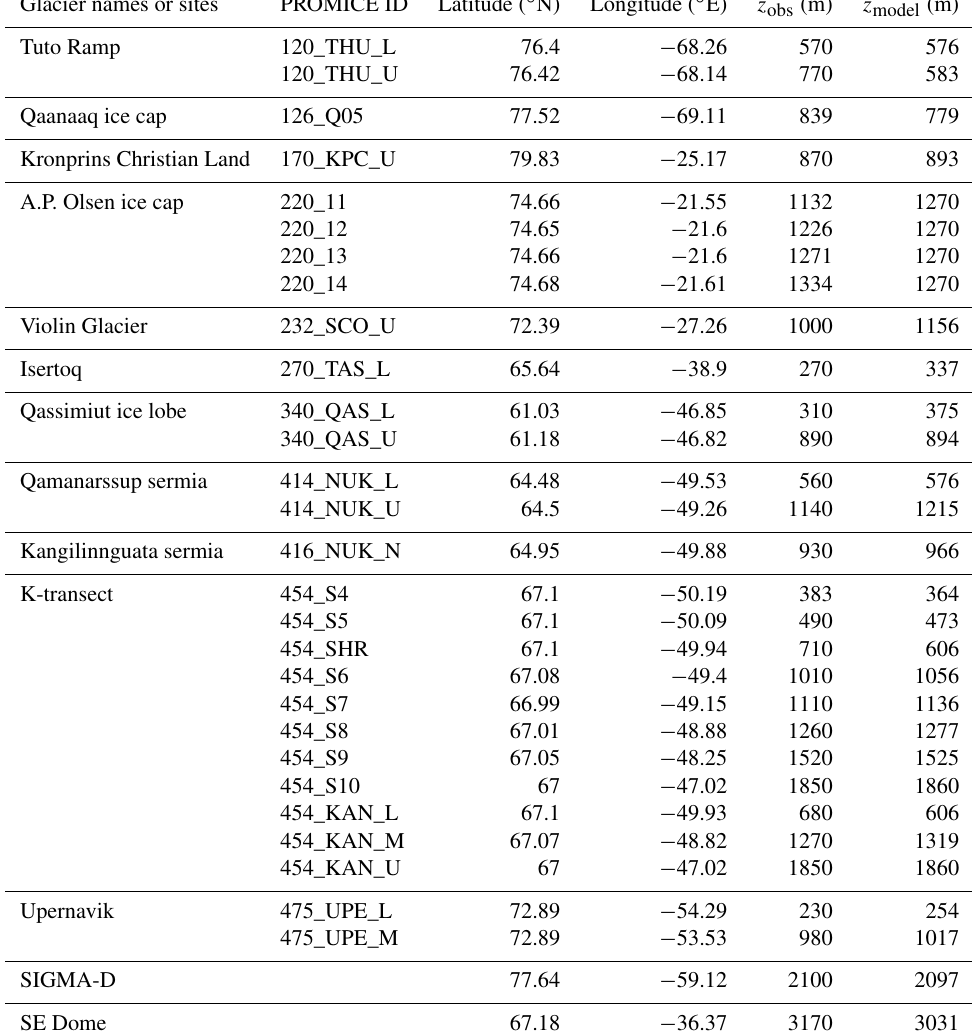
Table 2. Locations of observation sites for SMB, including the official ID for PROMICE sites and surface elevations measured on site ( z obs ) and specified in NHM–SMAP ( z model